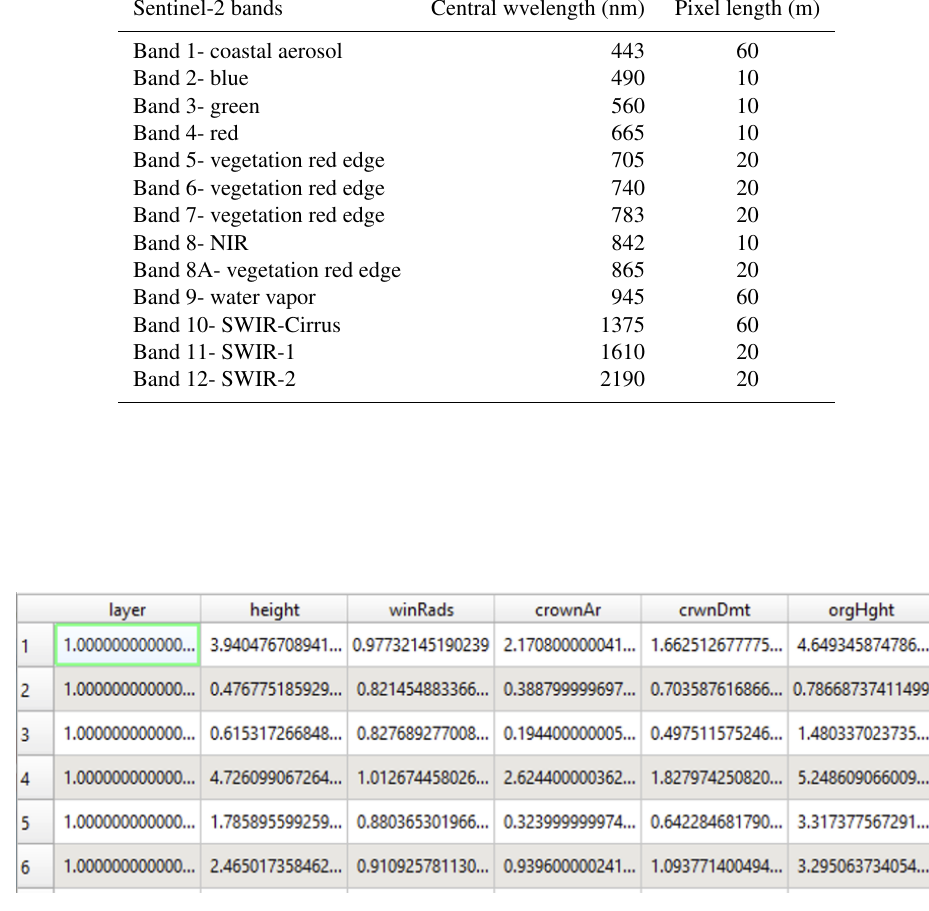
Figure A8. Screenshot of the crowns_polygon shapefile attribute table for plot EN18077 as an example. Height: tree height in meters as identified with the tree-top finding algorithm, crownAr: area of the tree crown in square meters, CrwnDmt: simplification of the crown diameter in meters assuming a circular crown, orgHght: maximum height value in meters recorded in the canopy height model (CHM) under the total crown